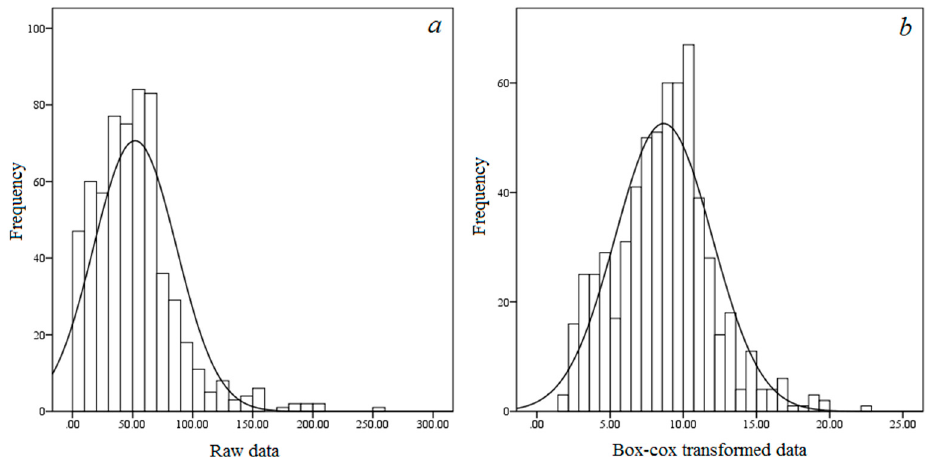
Figure 2. Histograms of raw and Box-cox transformed vegetation carbon density (including tree, understory vegetation and litter layers) in Pinus massoniana forest. ( a ) and ( b ) represent raw and Box-cox transformed vegetation carbon density, respectively.